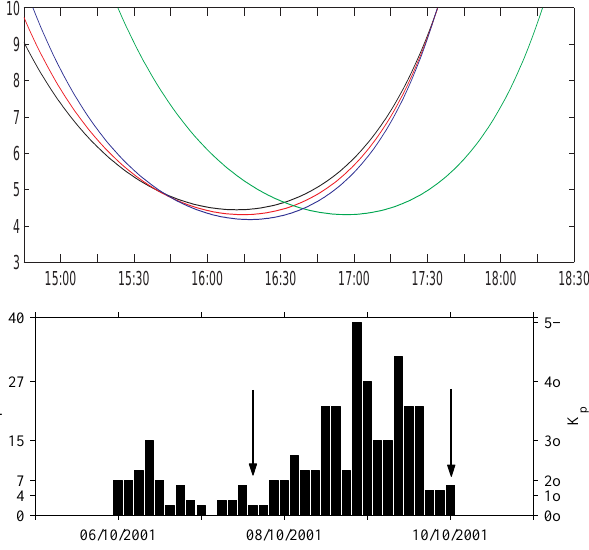
Fig. 3. Top panel: orbit of the 4 Cluster satellites versus time on 7 October 2001 (1: black; 2: red; 3: green; 4: blue); bottom panel: evolution of the A p and the K p indices during 6–10 October 2001 period, the arrows point at the time of the Cluster perigee